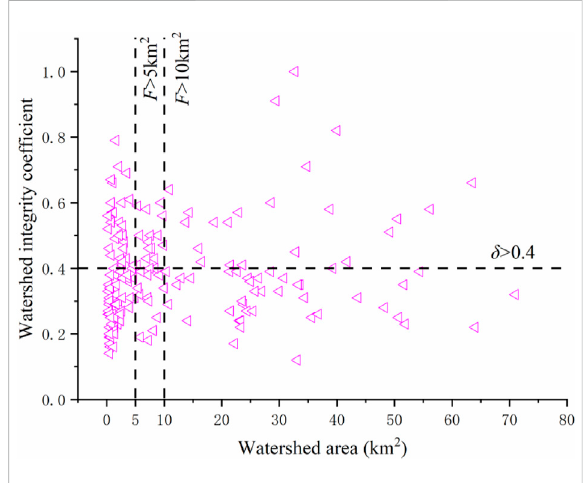
FIGURE 3 Watershed integrity coef fi cients versus watershed area of 176 channel-type debris fl ow gullies in the meizoseismal areas.